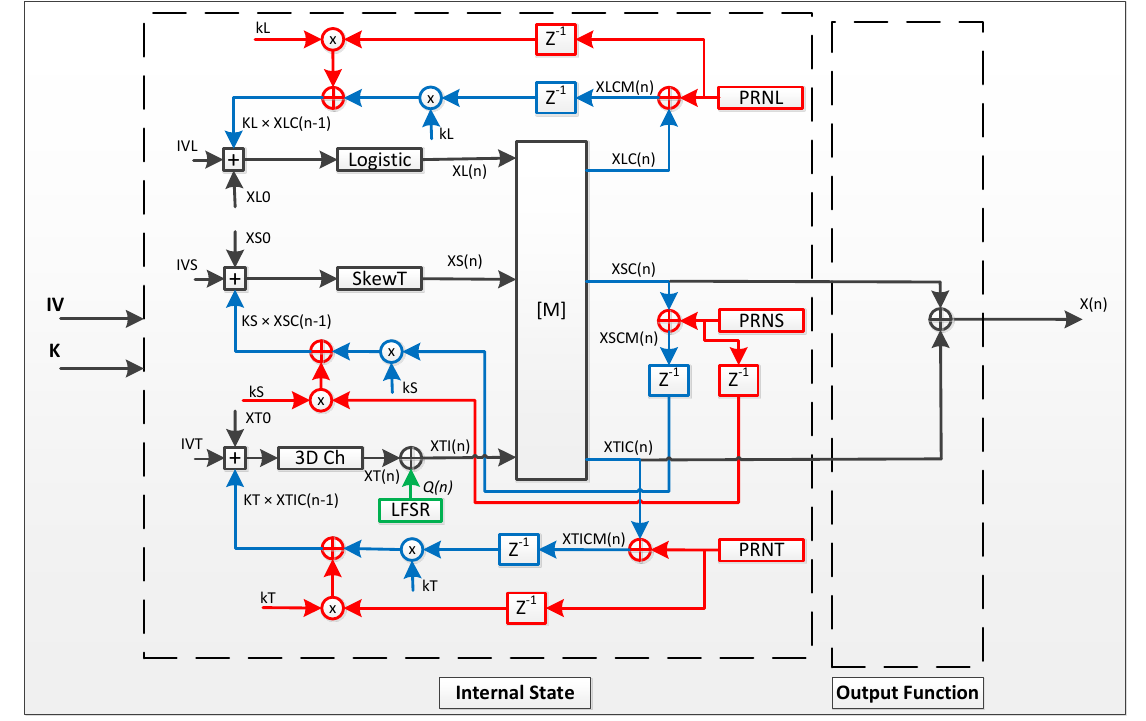
Figure 2. Architecture of the proposed SPCNG. The M-matrix weak coupling technique creates an interdependence between the three chaotic maps that avoids an attacker using the divide and conquer approach on the